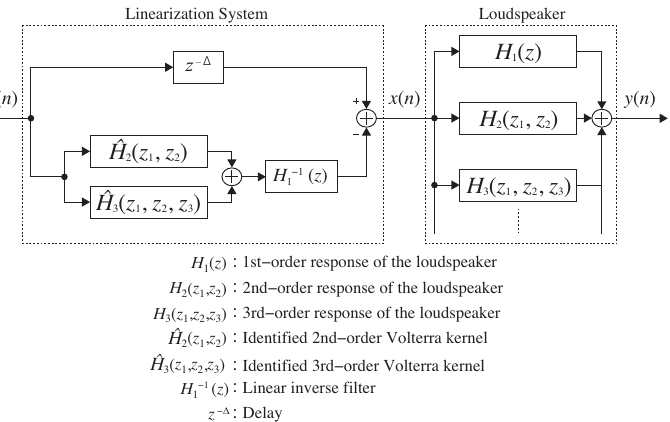
Figure 1. Block diagram of the 3rd-order linearization system for loudspeakers with higher-order non- linearity.